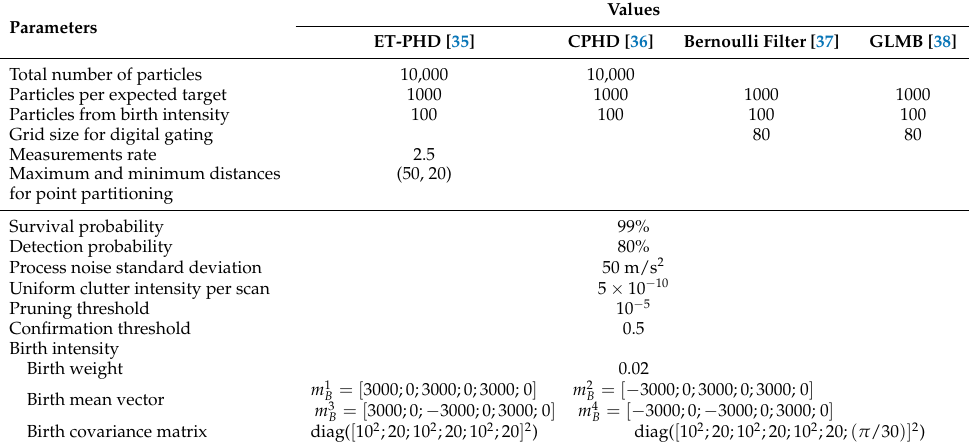
Table 3. Parameters of